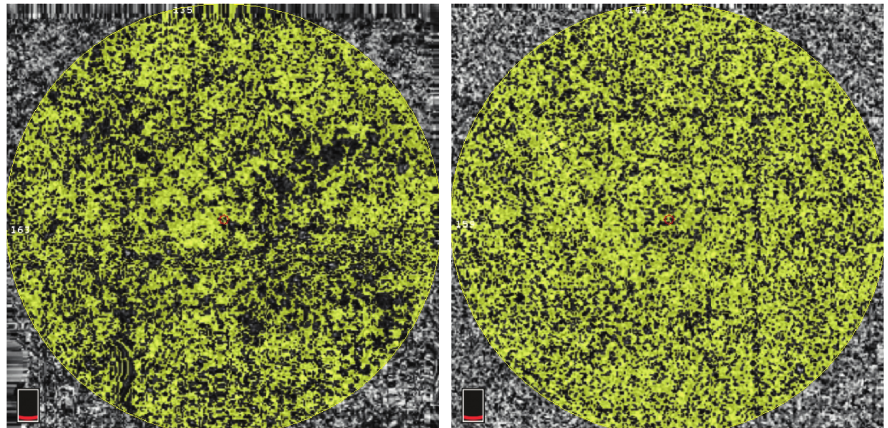
Figure 3: Choriocapillaris obtained by OCTA of the retina from a patient suffering from type 2 diabetes (a) and a subject who is healthy